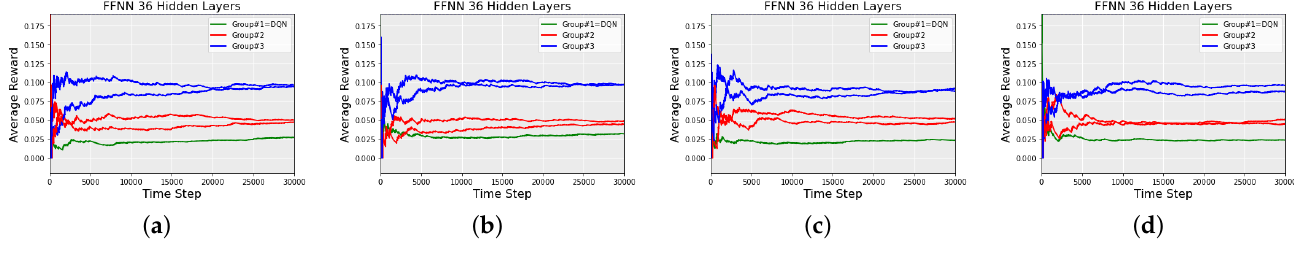
Figure 11. Reward convergence of a heterogeneous leader-follower MAS, including N = 5 agents in P = 3 different clusters, during 30,000 time steps by considering time-delay and distance-based reward after adversarial attack defense Algorithm 1. ( a ) Average reward of a leader-follower MAS without adversarial attack. ( b ) Average reward of a leader-follower MAS after defending against FGSM adversarial attack. ( c ) Average reward of a leader-follower MAS after defending against FGM adversarial attack. ( d ) Average reward of a leader-follower MAS after defending against BIM adversarial attack.